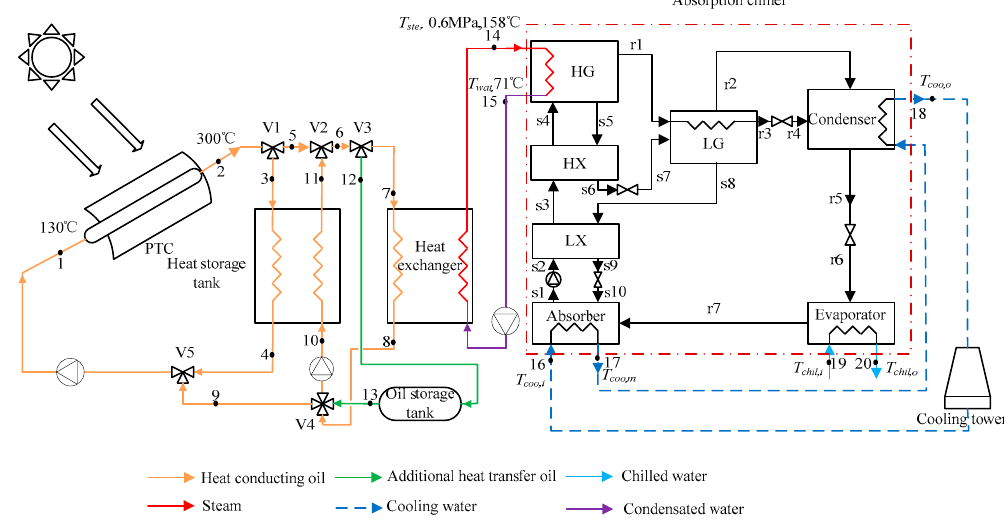
Figure 1. Double-effect LiBr–H 2 O absorption chiller system driven by parabolic trough collector (PTC). HG—high-pressure generator; HX—high temperature exchanger; LG—low-pressure generator; LX—low temperature heat exchanger.